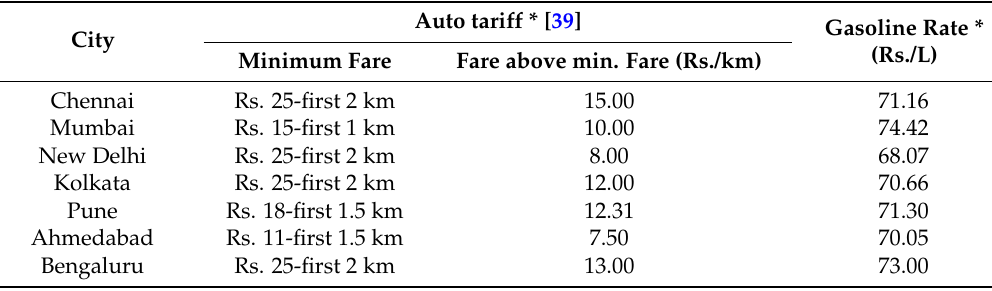
Table 7. Auto fare and gasoline rate at key urban regions of India. Auto tariff * [39] Gasoline Rate * City (Rs./L)Minimum